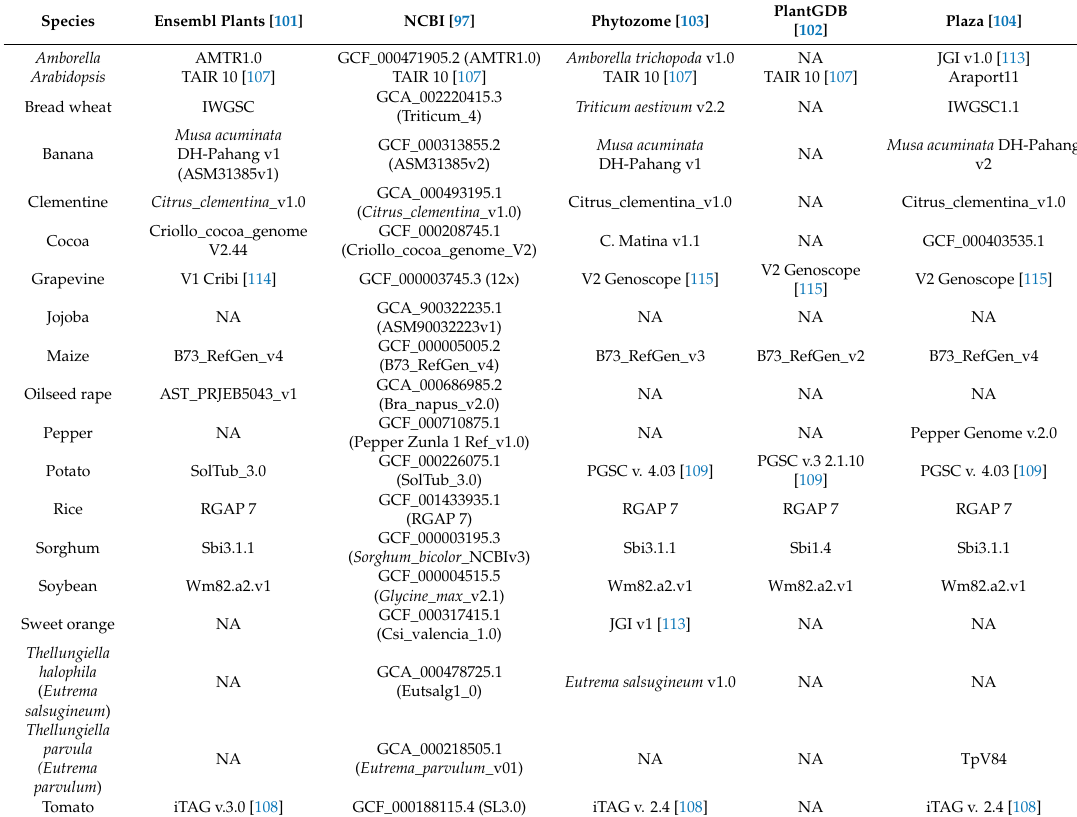
Table 1. Gene annotation version of model plants or plants of agronomic interest as reported in public web accessible